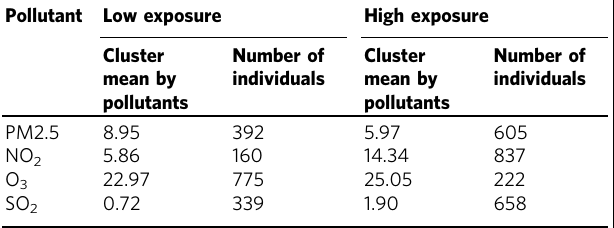
Table 1 Summary of k -mean